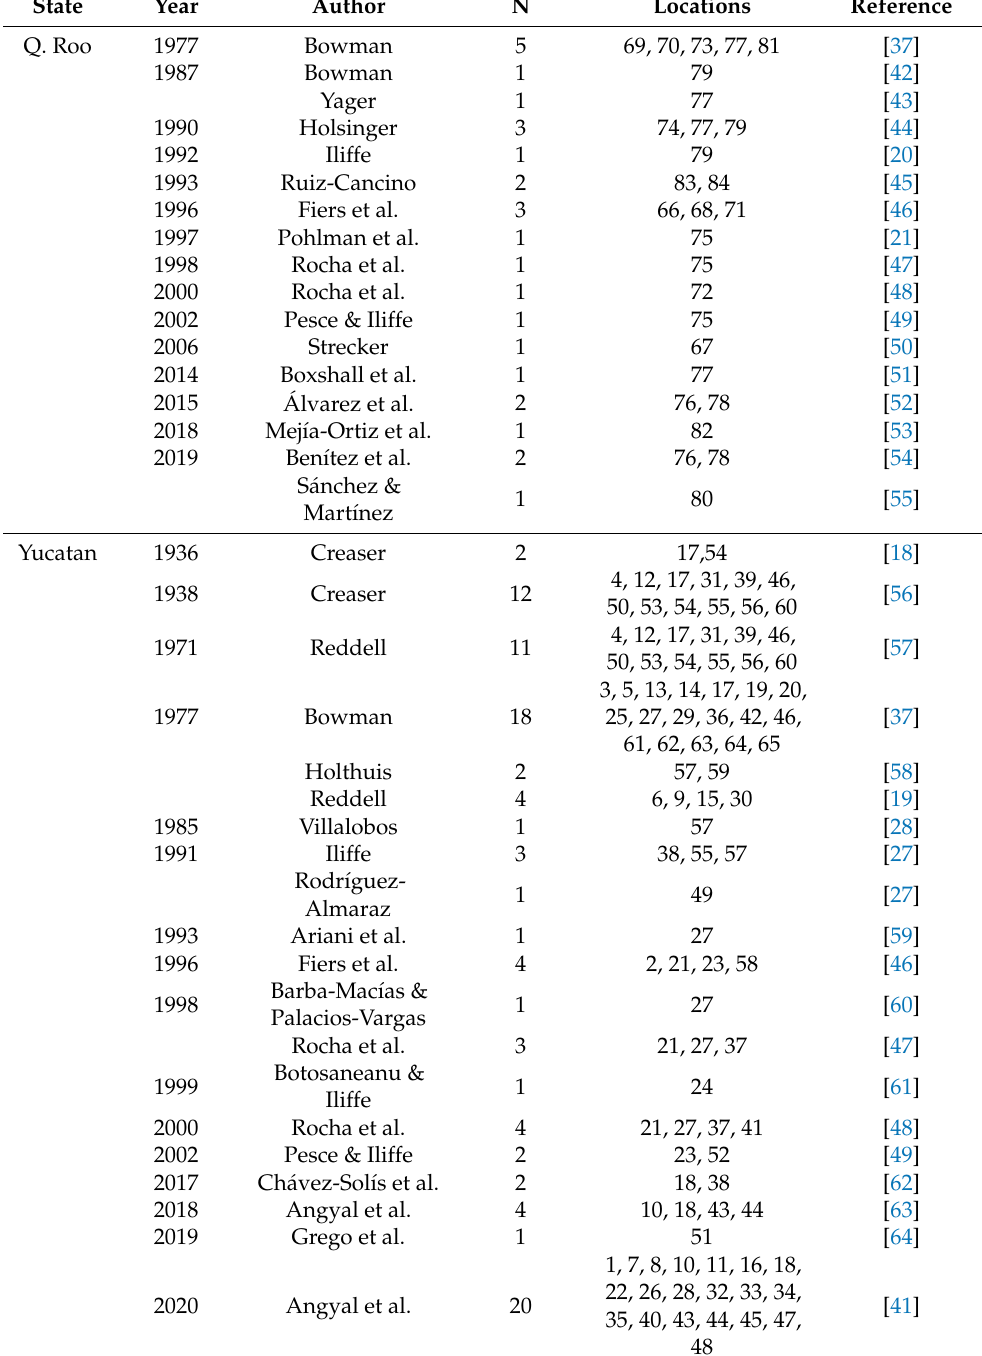
Table 1. Locations where A. cenotensis records have been published per year for the states of Quintana Roo and Yucatan. Location geographical distribution and names can be found in Figure